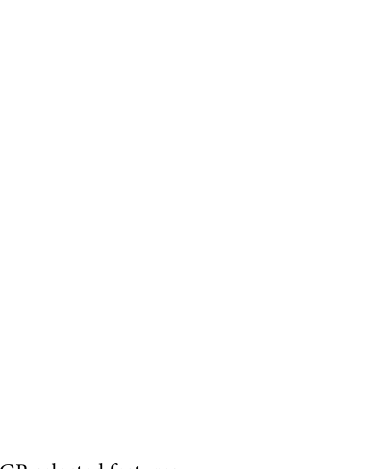
Figure 4. Average confusion matrix of DF-COVID-19 with Wei_IGR selected features.